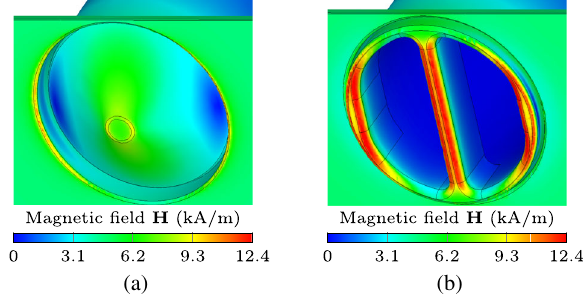
FIG. 8. Magnetic field at the tips of tuner and vacuum pumping port. The peak surface currents on the vacuum port are signifi- cantly higher, resulting in a larger impact on Q 0 . (Identical color scales are used for easier